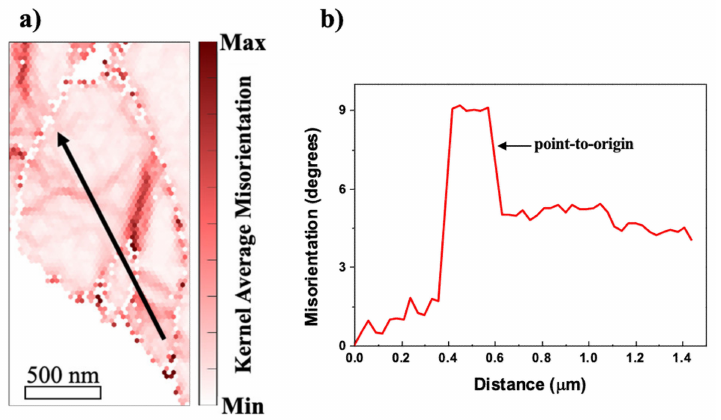
Figure 5. ( a ) Kernel average misorientation map of AM5 indicated in Figure 4b (region 1) with the arrow marking ( b ) misorientation profile.